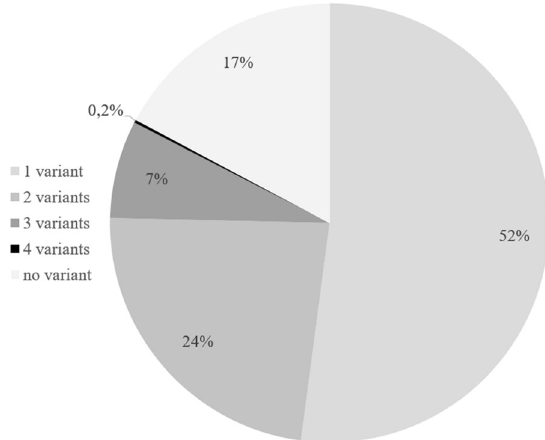
Fig. 5 Pie chart of the number of variants that were found per sacroiliac